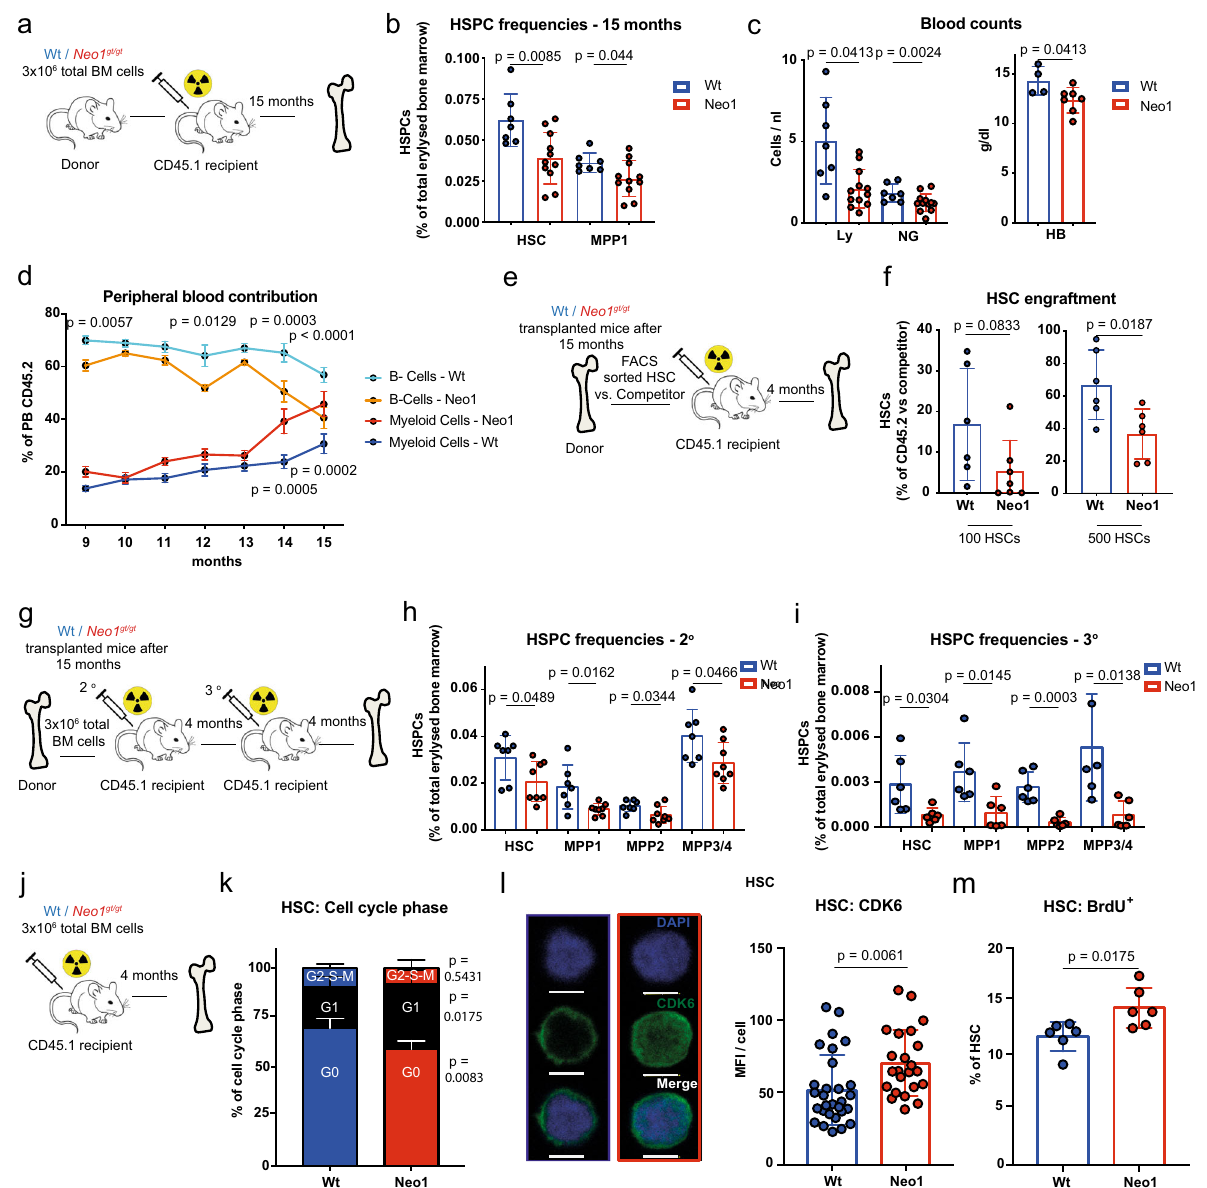
Fig. 3 Mutant Neo1 causes premature HSC exhaustion. a Work fl ow: aged chimeras, analysed in ( b – d ). b Absolute frequencies of bone marrow CD45.2 + HSPCs in full Wt and Neo1 gt//gt chimeras after 15 months; n = 7 (Ctrl) – 11 (Neo1), two independent experiments. c Absolute blood counts of full Wt and Neo1 gt//gt chimeras after 15 months; n = 7 (Ctrl) – 11 (Neo1), two independent experiments, for HB: 4 (Ctrl) – 7 (Neo1). d Frequencies of B cells and myeloid cells of C45.2 + cells in peripheral blood of Wt and Neo1 gt//gt chimeras after 15 months; n = 5 – 13 (for exact n /timepoint please see Source data fi le), two independent experiments. Analysis with two-way-ANOVA, multiple comparisons with LSD Fisher ’ s test. e Work fl ow: assessment of HSC potency derived from 15 months (aged) chimeras. f Frequency of CD45.2 + vs. competitor HSCs 16 weeks transplantation of 100 or 500 HSCs from of aged Wt and Neo1 gt//gt chimeras; n = 6 (Ctrl + 500 HSC Neo1) – 7(100 HSC, Neo1), two independent experiments. g Work fl ow: secondary and tertiary transplantations of 15 months (aged) chimeras. h Absolute frequencies of bone marrow CD45.2 + HSPCs in 2° transplantations of aged Wt and Neo1 gt//gt chimeras after 4 months; n = 7 (Ctrl) – 8 (Neo1), two independent experiments. i Absolute frequencies of bone marrow CD45.2 + HSPCs in 3° transplantations of aged Wt and Neo1 gt//gt chimeras after 4 months; n = 6, two independent experiments. j Work fl ow: generation of full chimeras used in ( k – m ). k Cell cycle phase of CD45.2 + HSCs derived from Wt and Neo1 gt//gt chimeras after 4 months; n = 4 (Ctrl) – 6 (Neo1), two independent experiments. l MFI of CDK6 in CD45.2 + HSC derived from Wt and Neo1 gt//gt chimeras after 4 months; n = 23 (Neo1) – 29 (Ctrl). m Frequency of BrdU + CD45.2 + HSC derived from Wt and Neo1 gt//gt chimeras after 4 months, 48h post BrdU injection; n = 6, two independent experiments. For all panels, ±SD is shown. n indicates biological replicates. P value was determined by two-tailed t test unless stated otherwise. Scale bars in IF images are 5 μ m. Source data are provided as a Source Data fi le.